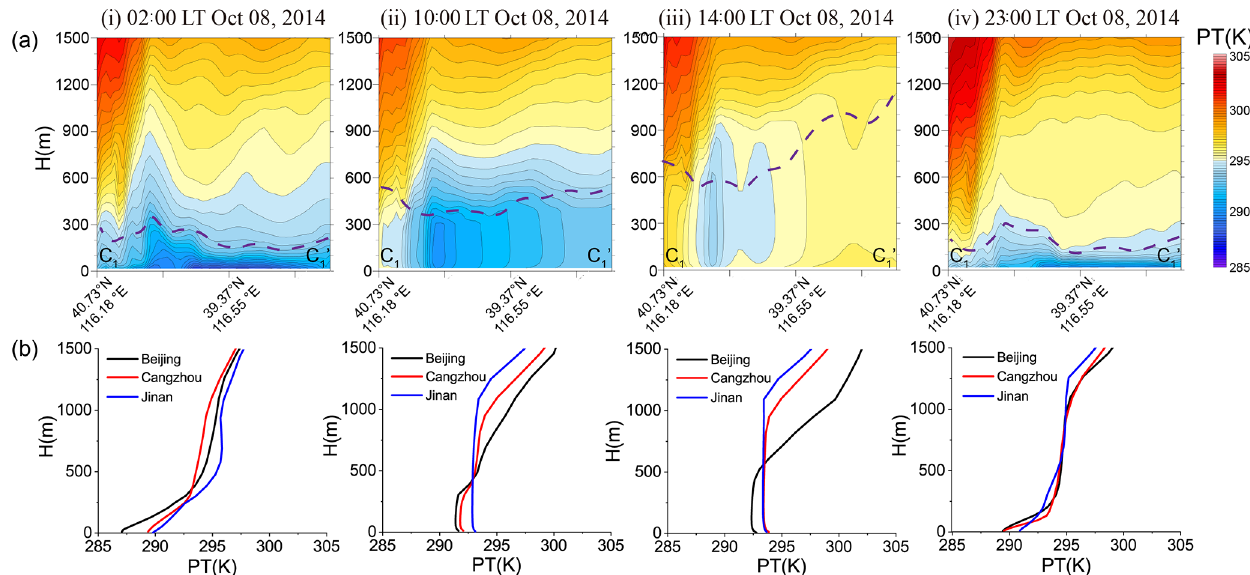
Figure 12. (a) Vertical cross sections and (b) vertical profiles of the simulated potential temperature at (i) 02:00LT, (ii) 10:00LT, (iii) 14:00LT and (iv) 23:00LT on 8 October 2014 in case 3 under the topographic obstruction category. The cross sections along the line C 1 C (cid:48) are shown in Fig. 6c, iii, iv. The dashed purple lines in (a) indicate the PBL 1